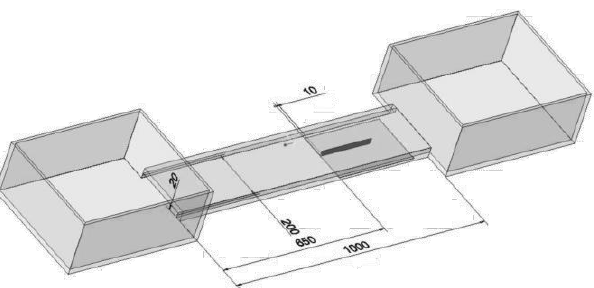
Fig. 8. Model of channel for initial experiments